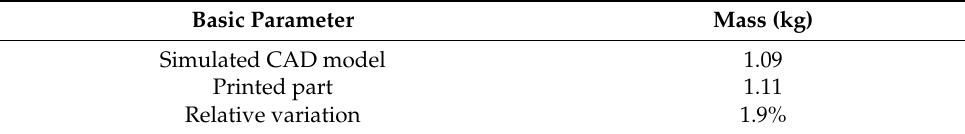
Table 3. Comparison of mirror’s